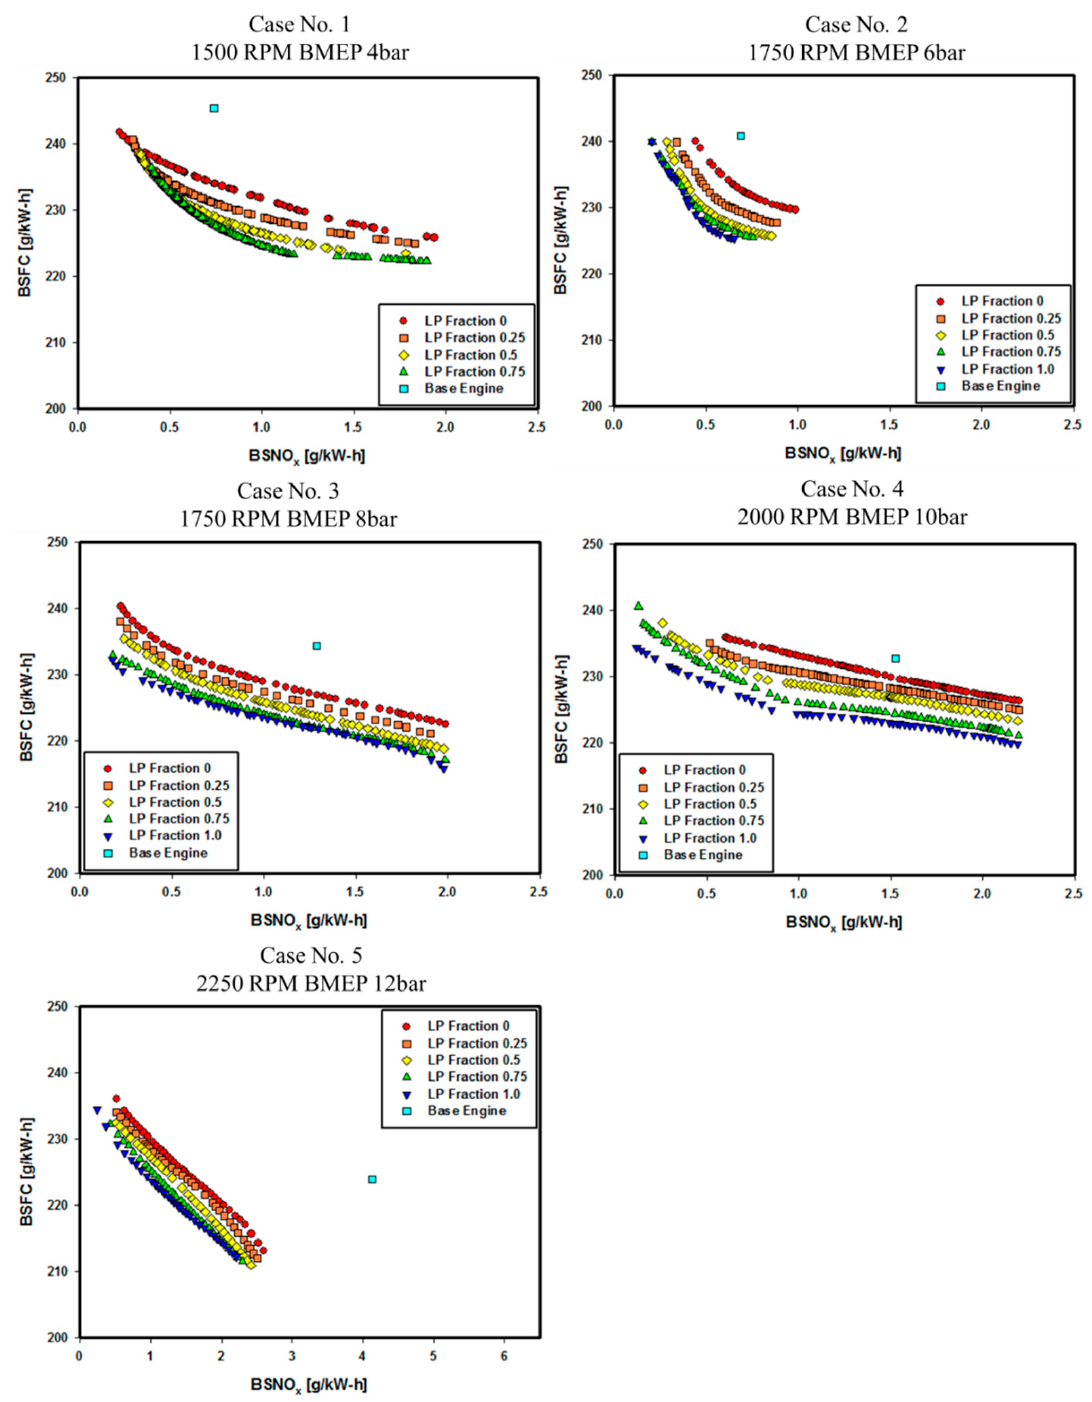
Figure 11. Pareto-optimal front with various low-pressure (LP) fractions for all cases. Figures 12–16 show the A / F variation through Pareto front lines and dominant A / F controlling factors: eS power versus rpm. The controlling parameters are discussed in detail in the next